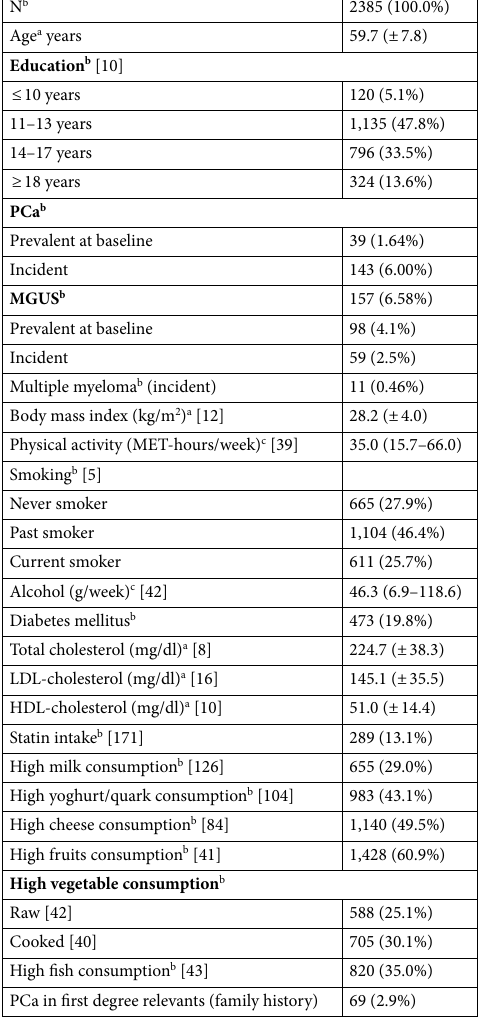
Table 1. Characteristics of the male study participants of the Heinz Nixdorf Recall (HNR) study. MGUS monoclonal gammopathy of undetermined significance, PCa prostate cancer. a Mean (± standard